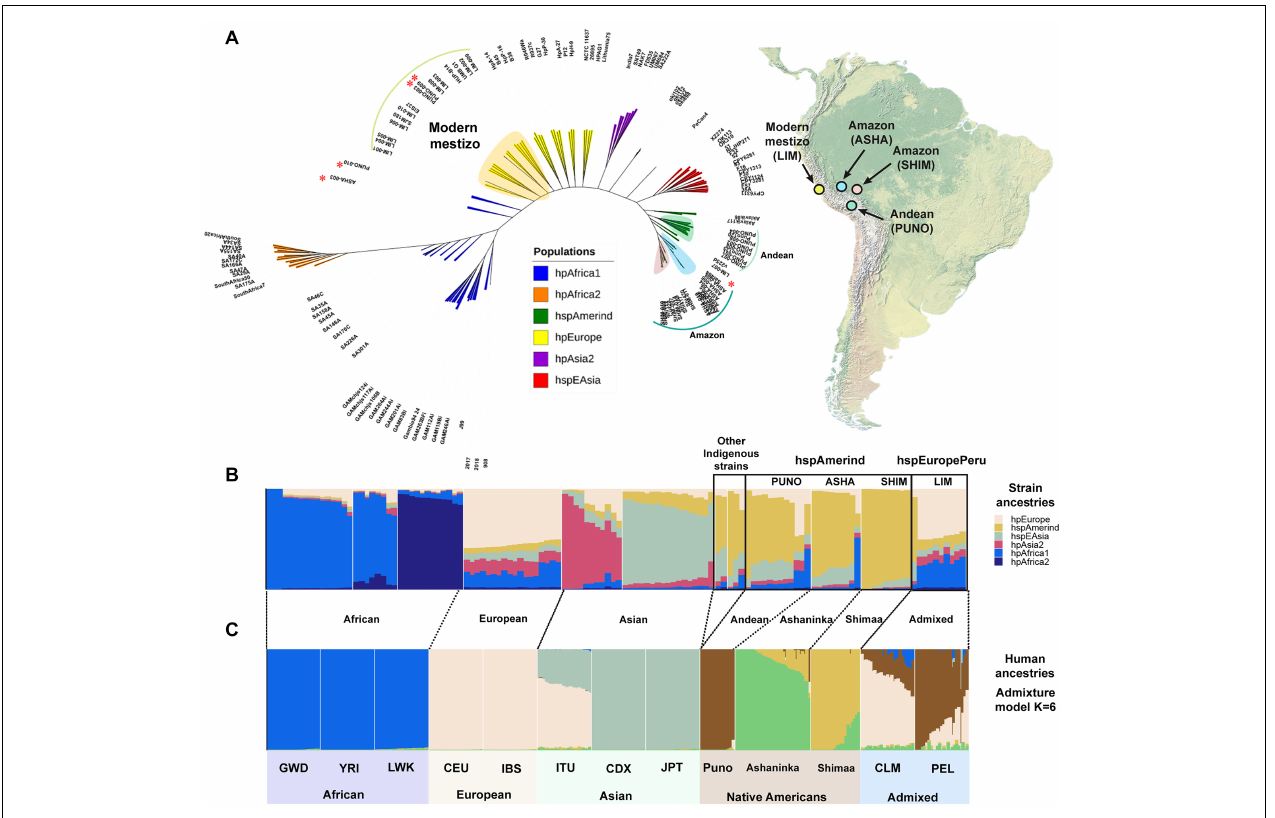
FIGURE 2 | Phylogenomic relationships and population structures of H. pylori and human populations. (A) Global phylogenomic tree for 127 H. pylori strains. The tree was constructed from a total of 930,403 SNPs with a K value of 29 using KSNPV3.0. The shading blue (ASHA) and red (SHIM) are the strains obtained from the Amazon, the light green (PUNO) are the strains isolated from Puno in the Andes, and the light yellow (LIM) represent the strains isolated from Lima. The Peruvian map shows the regions where the samples were collected. The asterisks represent the heavily admixed strains (ASHA-003, PUNO-003, PUNO-009, PUNO-010, and LIM-007). (B) Ancestry profiles inferred using Chromopainter v2/fineSTRUCTURE for 127 H. pylori strains (32 study and 95 references; Supplementary Table S4 ). (C) ADMIXTURE results for 10 human populations from 1000 Genomes ( n = 250) and Borda et al. (2020) ( n = 74; Supplementary Table S1 ). We plot admixture results for the K value with the lowest cross validation error ( K = 6; Supplementary Figure S2 ).